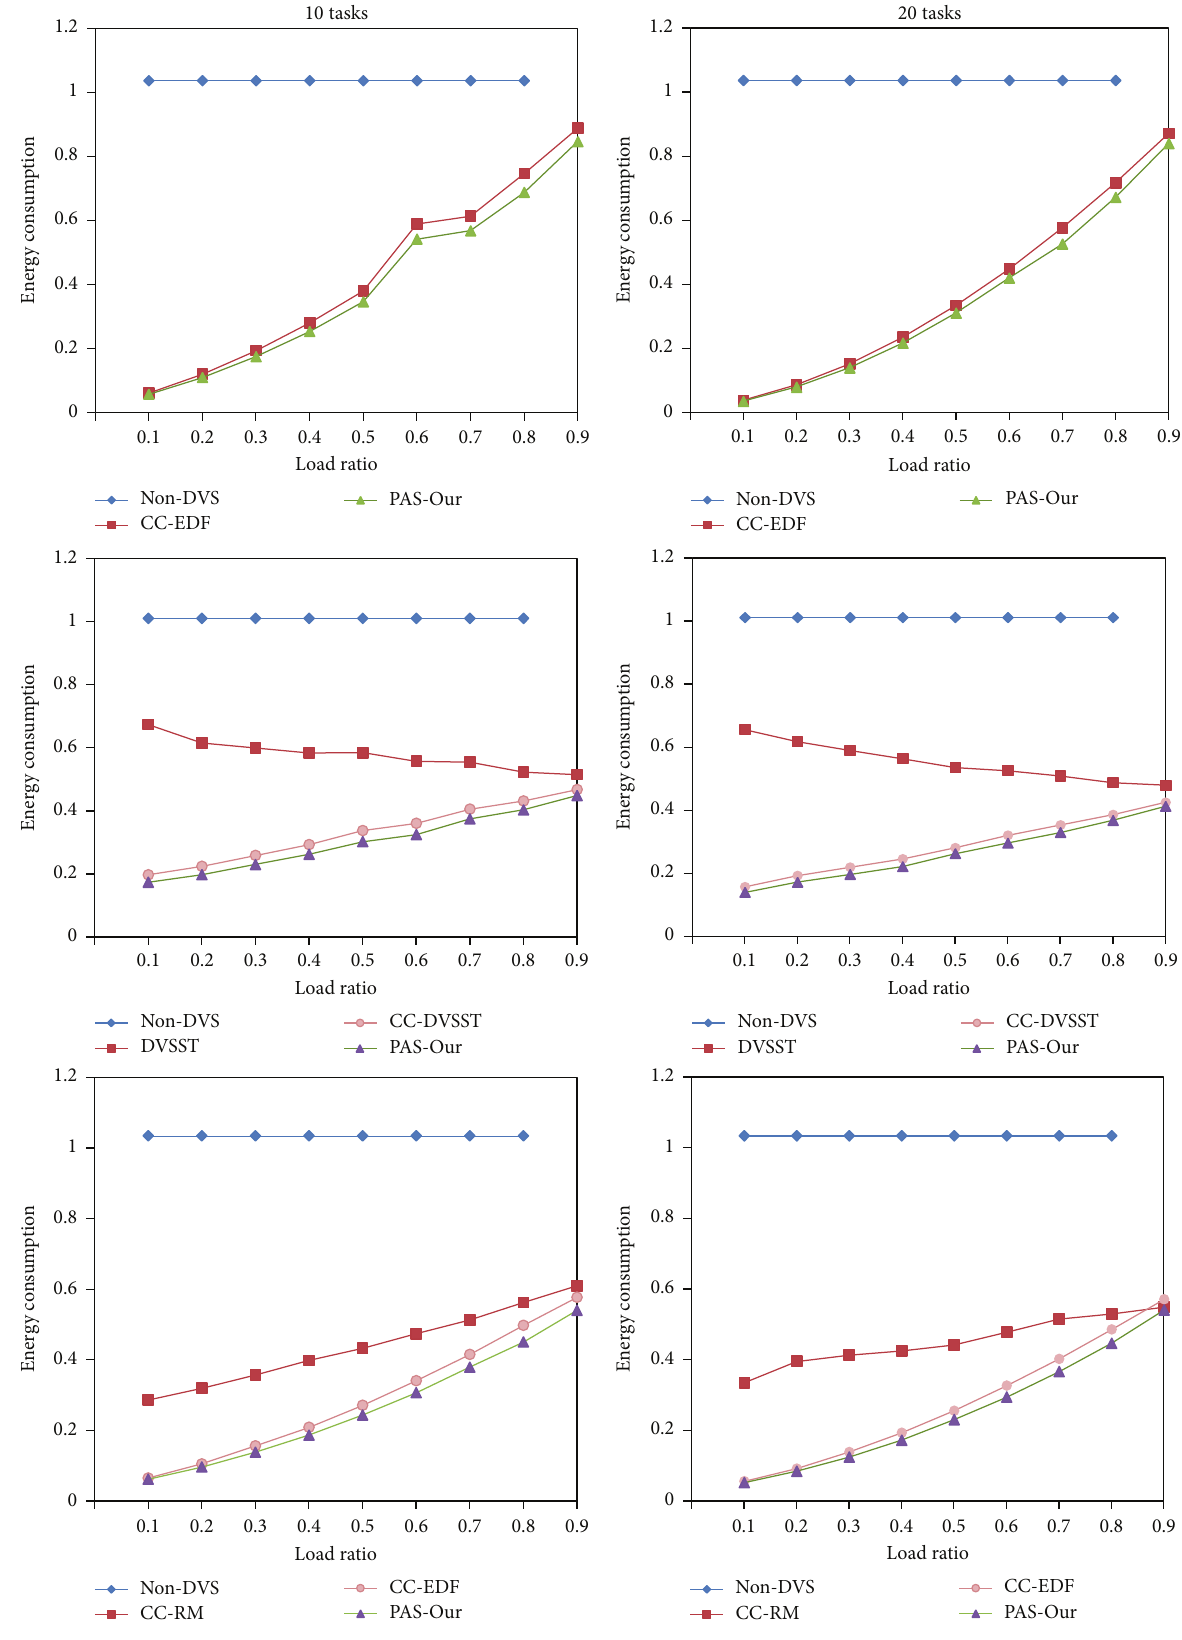
Figure 8: Simulation result for periodic, sporadic, and pinwheel